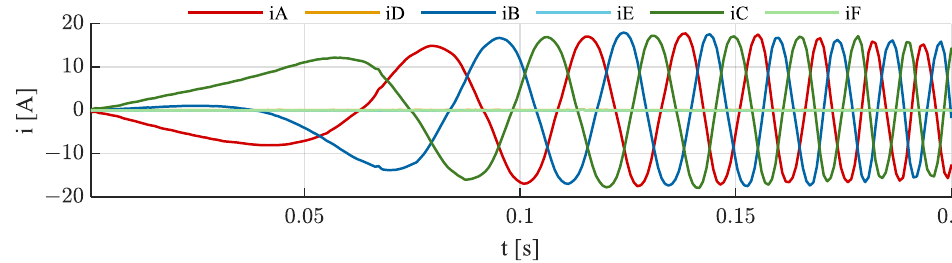
Figure 11. Phase current during the startup transient of three-phase operation.